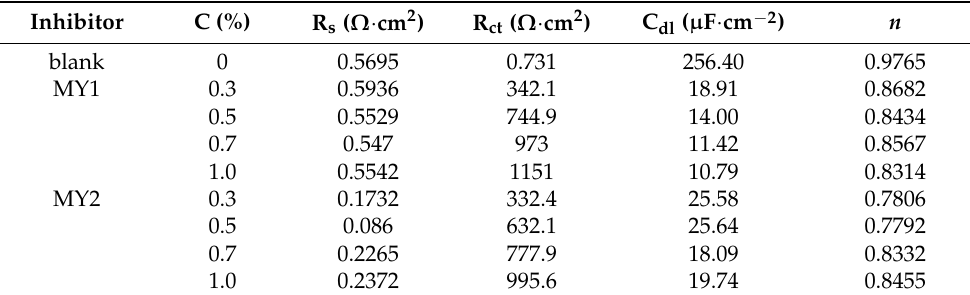
Table 2. Electrochemical impedance spectroscopy fitting